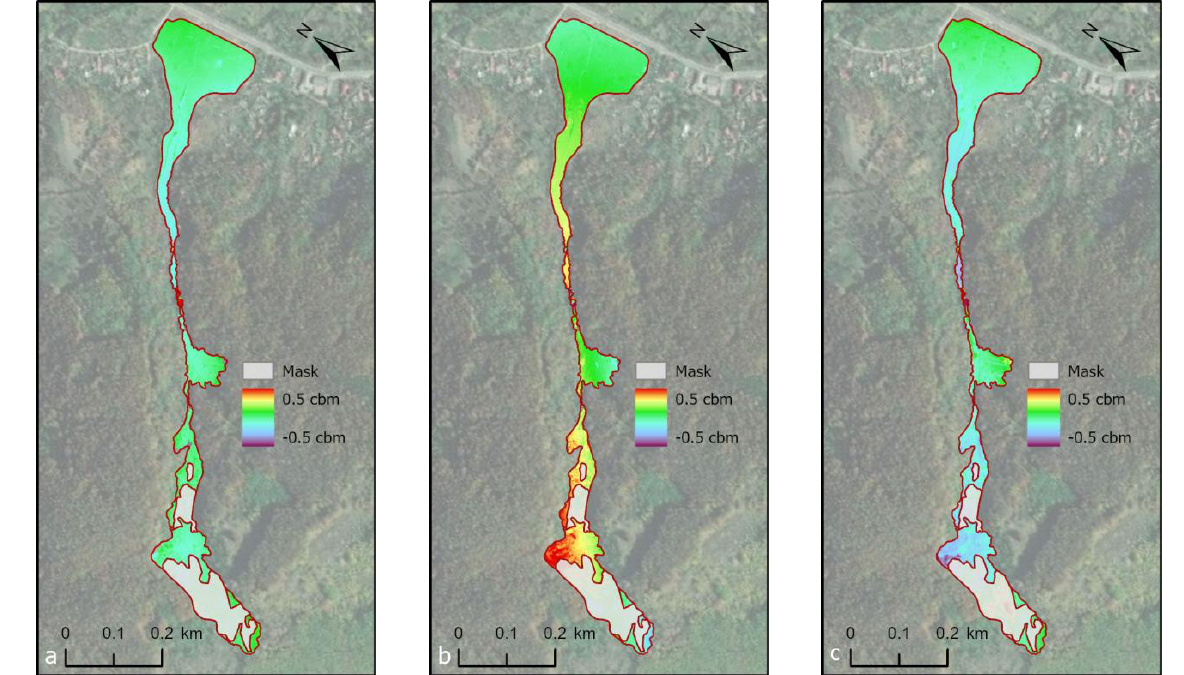
Figure 9. Earthflow changes between 2018 and 2022. From left to right: ( a ) 2018 to 2019; ( b ) 2019 to